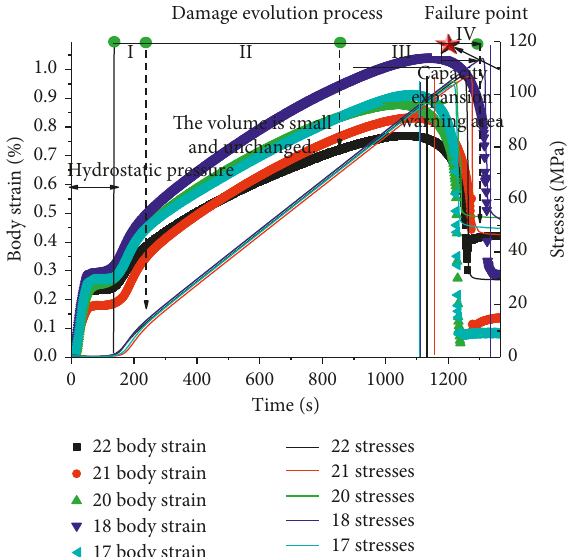
Figure 6: The relation curve of body strain stress and damage evolution